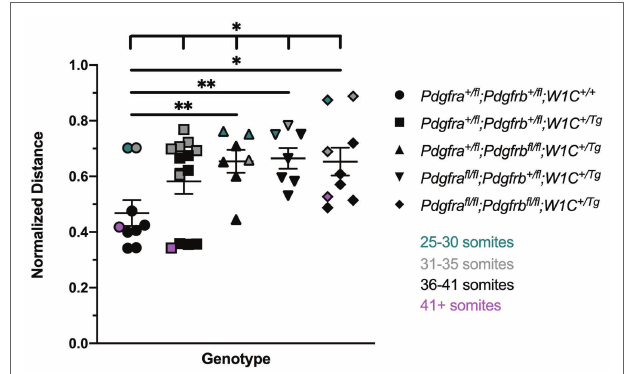
FIGURE 1 | Ablation of Pdgfra and Pdgfrb in the neural crest cell (NCC) lineage leads to increased distances between the nasal pits at mid-gestation. Scatter dot plot depicting the normalized distance between nasal pits across five genotypes at E10.5. Data are presented as mean ± SEM. * p < 0.05; ** p < 0.01. Colors correspond to number of somite pairs in assayed